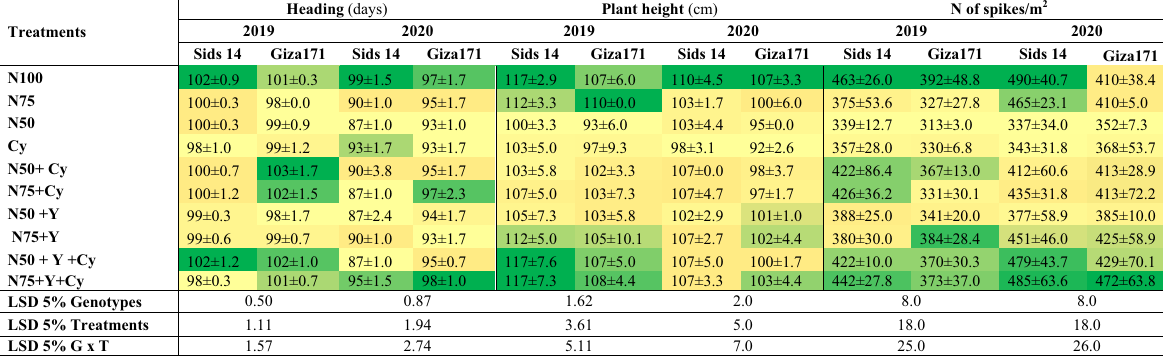
Table 4 Wheat yield components during vegetative growth stage (heading, plant height (cm) and number of spikes/m 2 ). Wheat crop was treated with cyanobacteria (Cy), yeast (Y) and mineral fertilization (N; nitrogen dose) over two consecutive seasons (2019 and 2020). The color scale pattern was generated in Excel, lower values are denoted in yellow color, whereas higher values are depicted by a green color. Each value is mean of 3 independent replicates SE ± Treatments